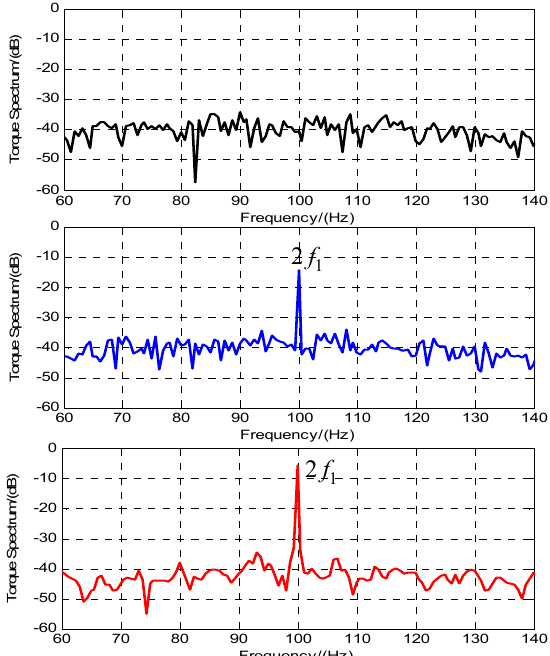
Figure 11. Torque spectrum for 5 turns shorted stator fault cases with di ff erent fault resistances (top: health, middle: R f = 1 Ω , bottom: R f = 0.1 Ω ).